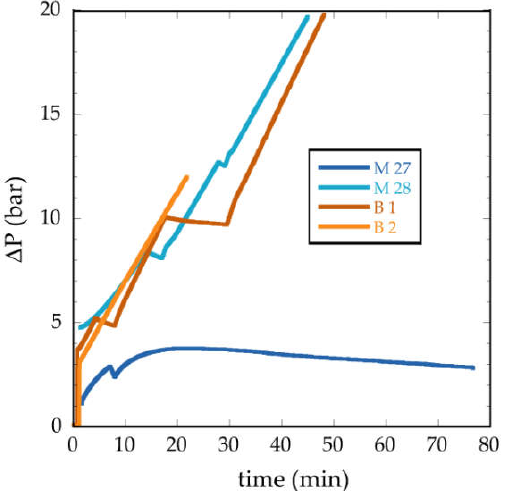
Figure 8. Experimental results for the water permeability tests performed with reefal carbonate (M) and Berea sandstone (B) porous samples. The curves denote the changes in pressure drop ( ∆ P ) versus time. Experimental data were measured every five seconds.